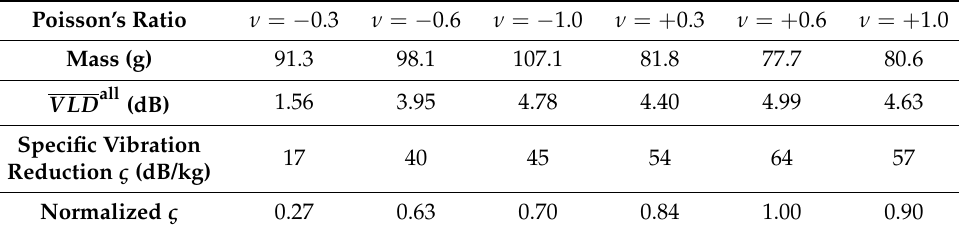
Table 4. Lightweight effect on vibration reduction